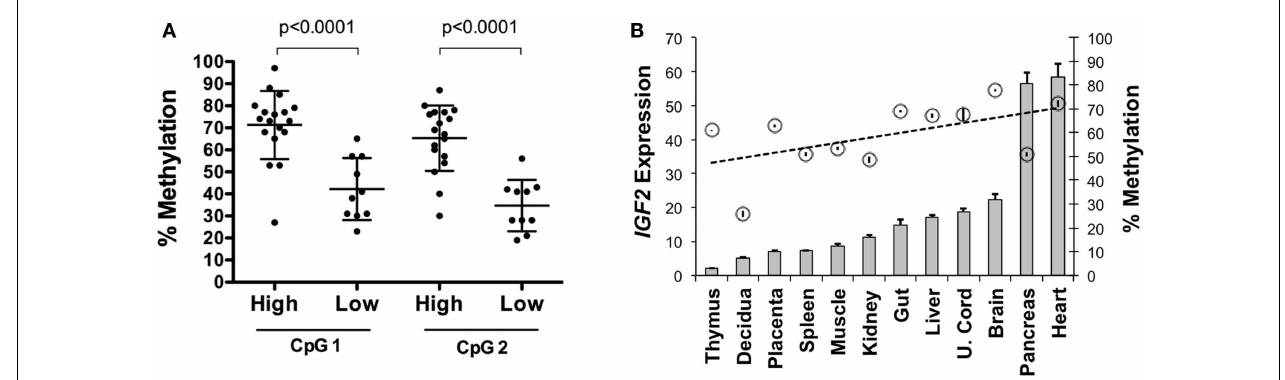
FIGURE 2 | IGF2 intragenic methylation and IGF2 transcription . (A) Methylation of the CpG within the IGF2 intron 3 CTCF binding motif (CpG 1) and adjacent CpG (CpG 2) in invasive serous ovarian cancers with very low IGF2 expression (Affymetrix U133A MAS5 values between 9 and 71, average = 26; labeled as “low”) compared to those with higher expression (MAS5 values between 128 and 24,056, average = 5,343; labeled as “high”).